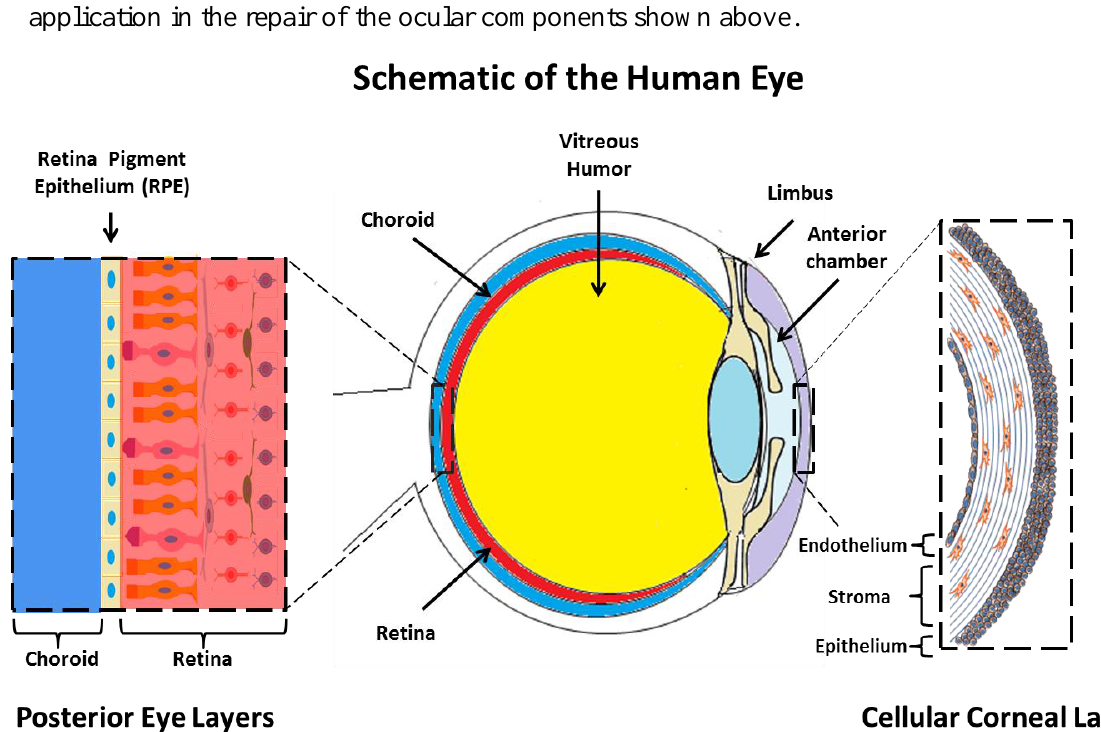
Figure 1. Schematic representation of the eye; gelatin-based materials have found application in the repair of the ocular components shown